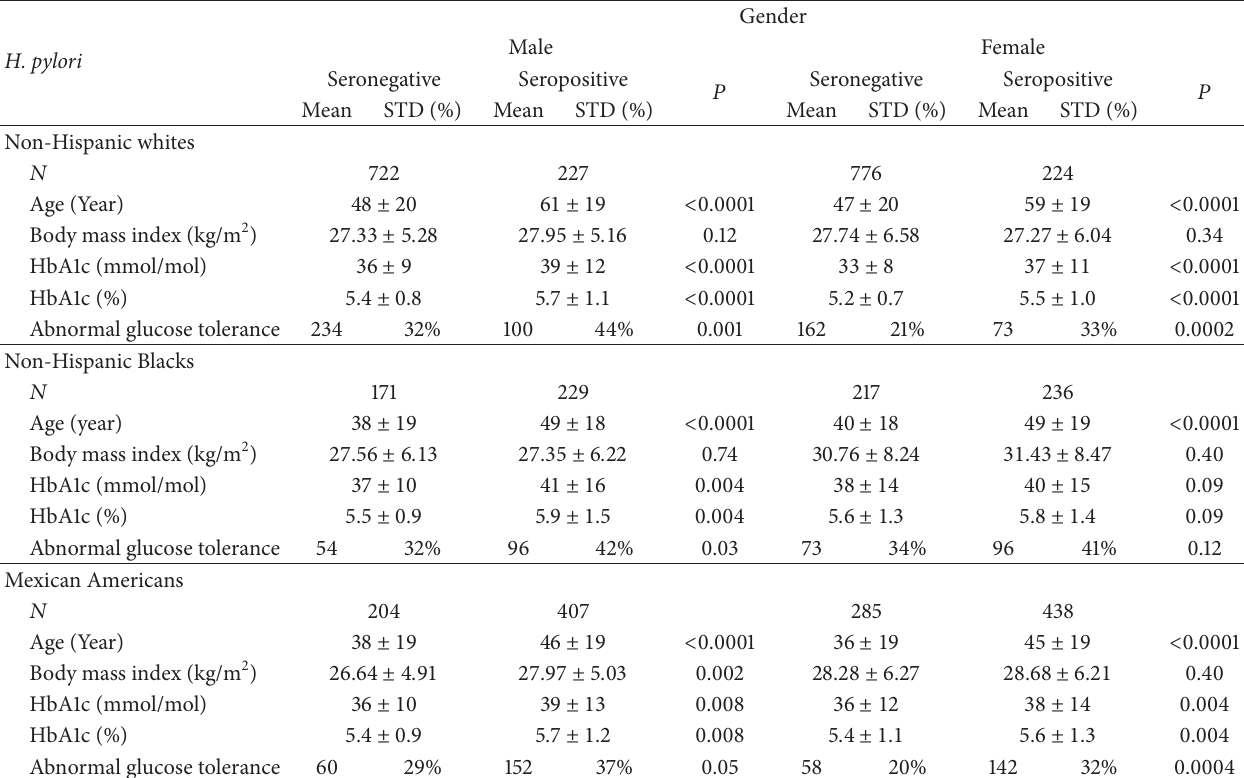
Table 2: Comparison of clinical characteristics by serological status of H. pylori .